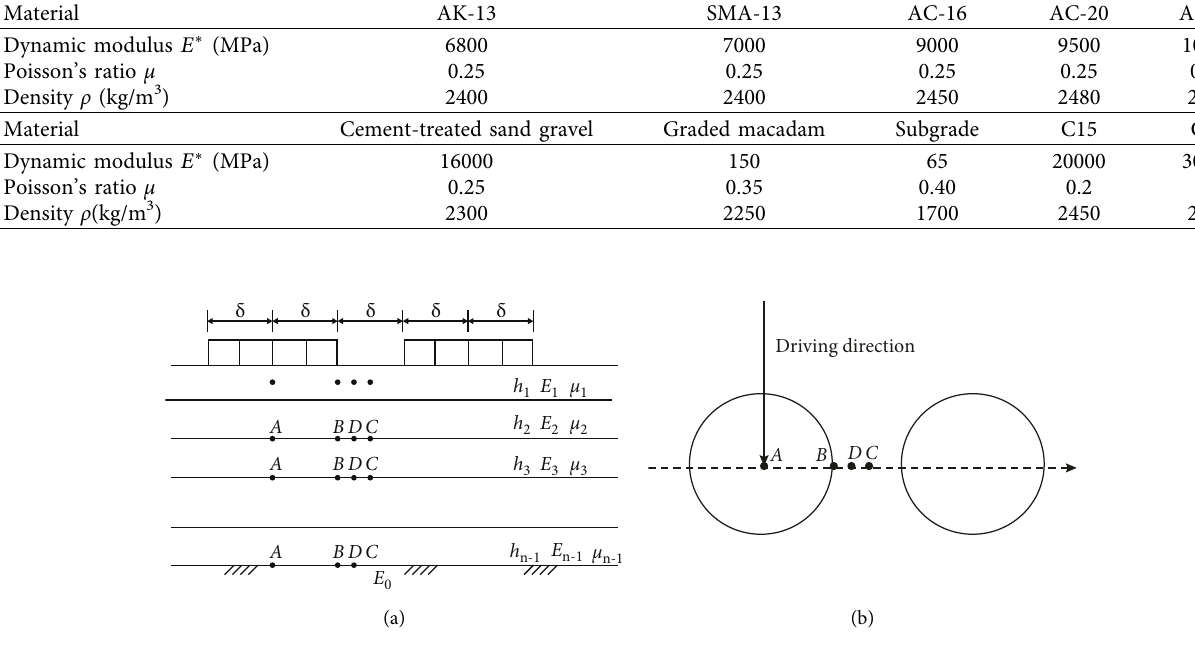
Tensile stress at the bottom of the cement treated layer along the driving direction